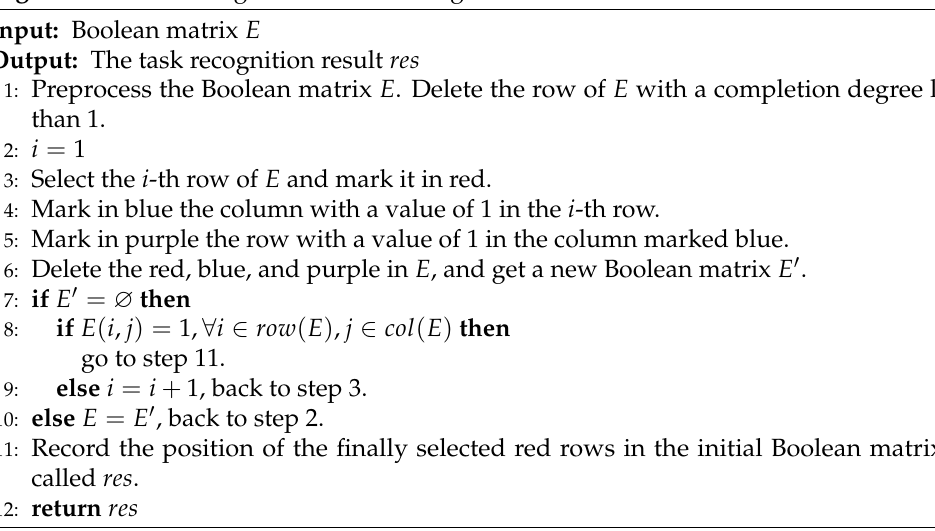
Algorithm 2 Task recognition based on Algorithm